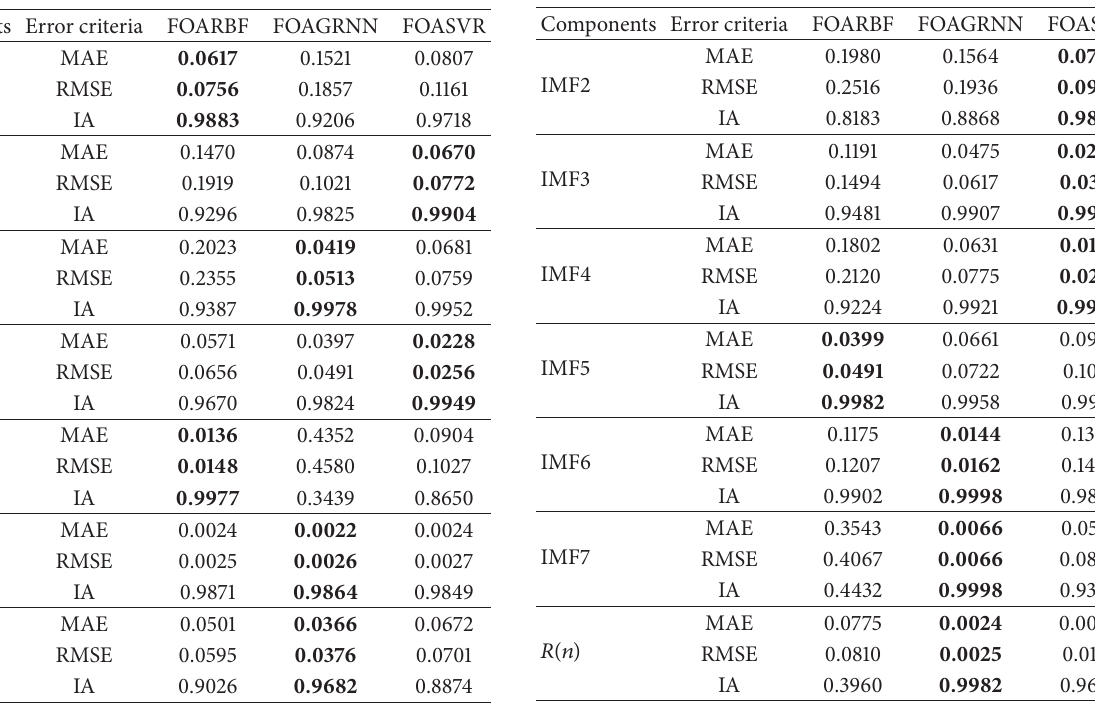
Table 7: The forecasting results of model selection among the FOARBF, FOAGRNN, and FOASVR in